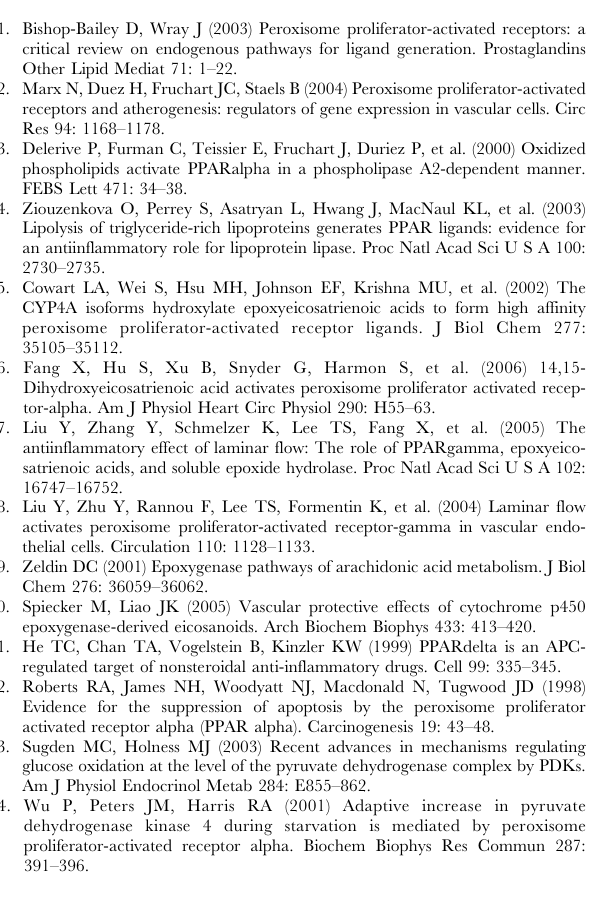
Table S1 Blood glucose and PDK4 expression in female fed and fasted wild type and CYP2J5 knockout ( 2 / 2 ) mice. Wild type and CYP2J5 2 / 2 mice have similar basal levels of plasma glucose. Following 24 h of fasting, blood glucose dropped in both wild type and CYP2J2 mice to equivalent levels, while the PPARalpha target gene PDK4 was induced to similar levels in the heart, liver and kidney. The non-PPARalpha target genes E1a and PDK2 (data not shown), were unaffected by fasting. Similar results were found in male mice. This data represents the mean 6 s.e.m. for n =4 animals per group. * denotes p , 0.05 by paired t-test between fed and fasted